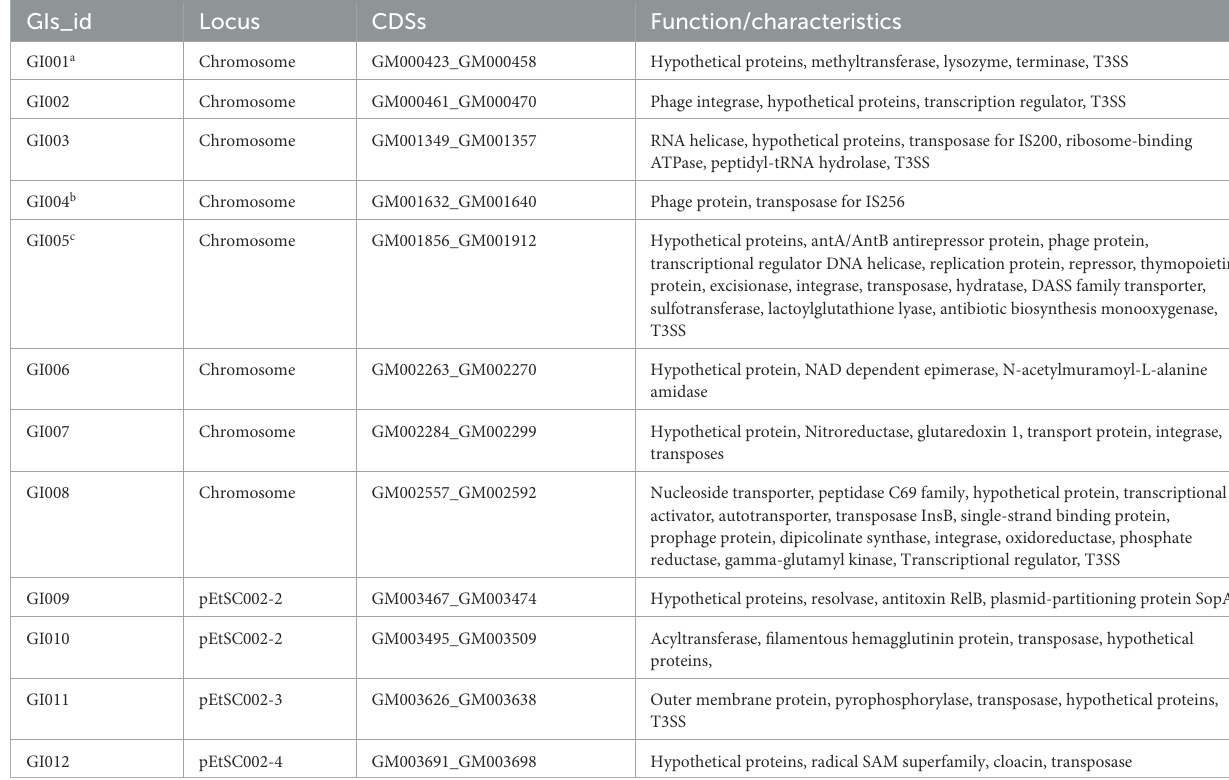
TABLE 2 Overview of the genomic islands in the Edwardsiella tarda SC002.